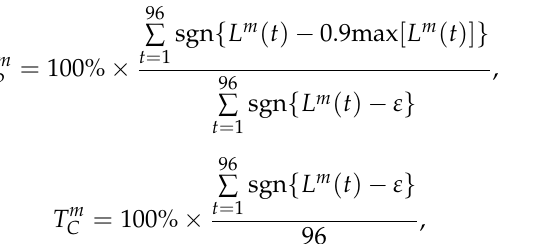
P i ( t ) . T m P i ∈ m